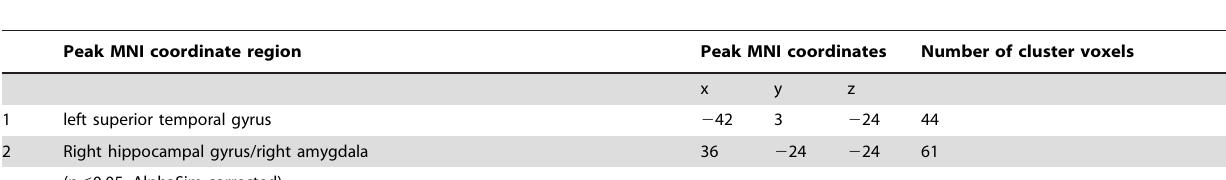
Table 1. Brain regions where functional connectivity with the PCC correlated with CAPS scores at the time PTSD patients were diagnosed.